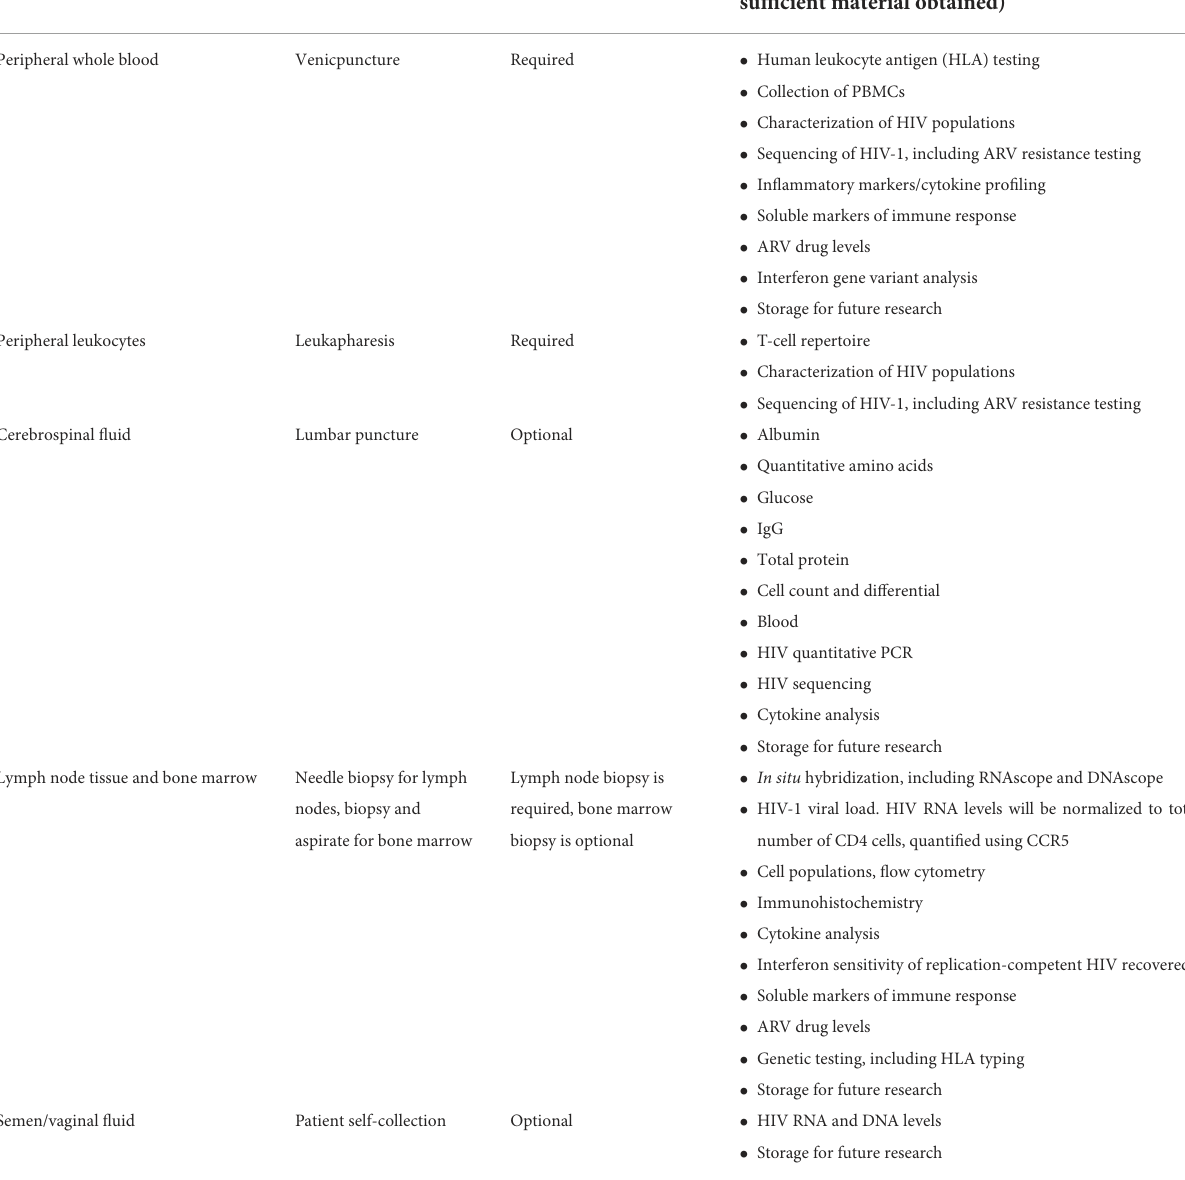
TABLE 2 Biospecimen